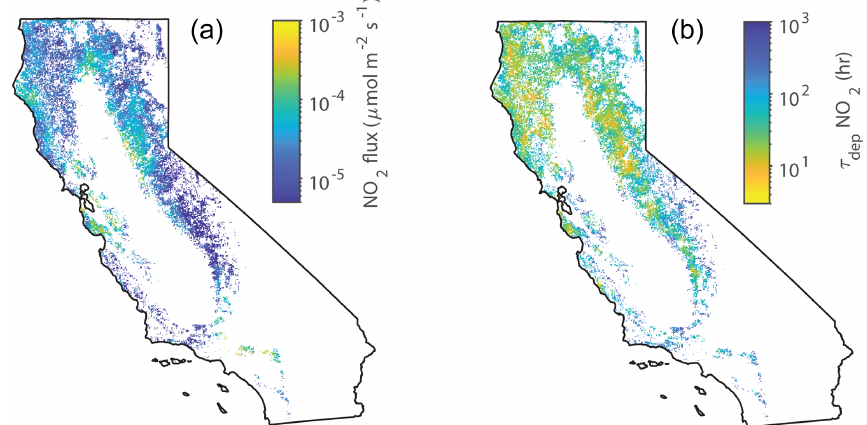
Figure 8. (a) Average midnight deposition fluxes of NO 2 to forests in June throughout California. (b) Average midnight deposition lifetimes of NO x in June throughout California. White areas are non-forested areas. Table 4. Comparison of total conductance measurements with previous works. Tree a Max g w t (this study) Reported max g w